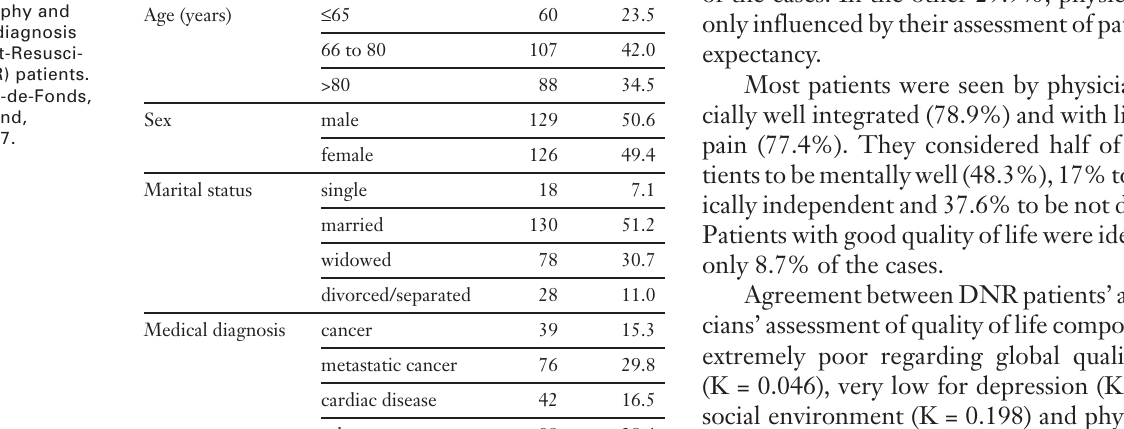
Demography and medical diagnosis of Do-Not-Resusci- tate (DNR)